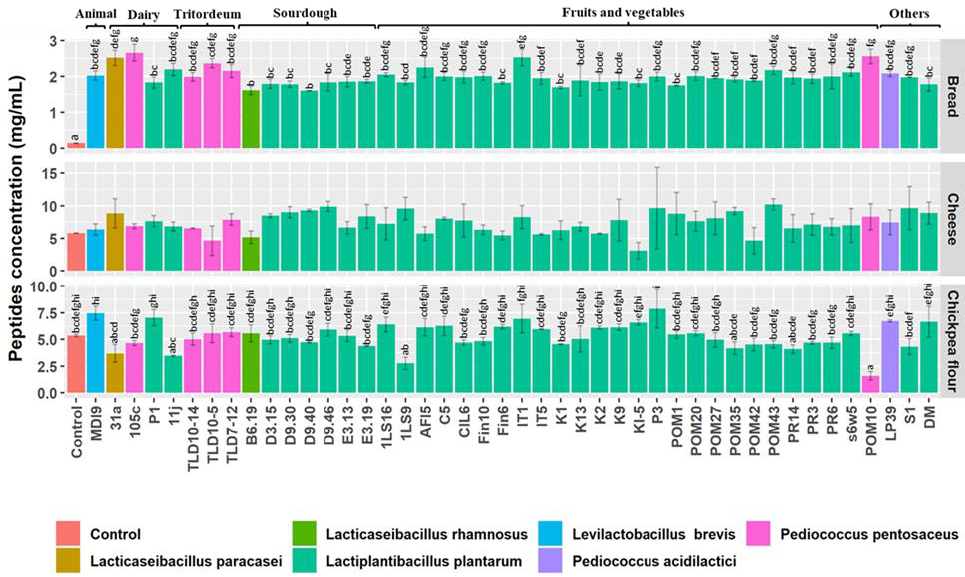
Figure 4. Peptide concentration values (mg/mL) in partially digested bread, cheese, and chickpea flour after 24 h incubation at 30 °C with 44 high-resistant lactic acid bacteria strains belonging to different species and isolated from different sources. Data are expressed as the mean of three separate analyses ± standard deviations. Bars with different superscript letters differ significantly ( p < 0.05).